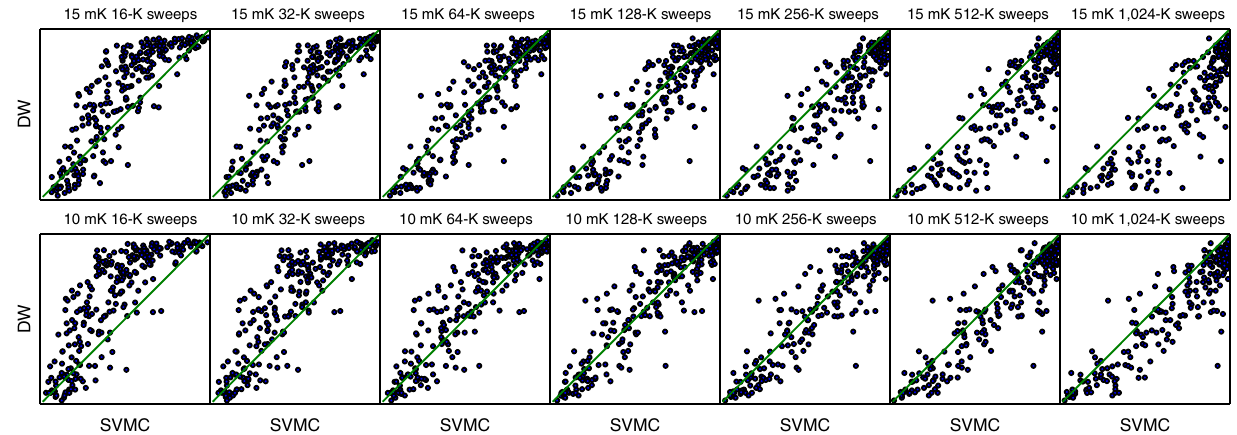
Figure 8 | Scatter plots showing the correlation of D-Wave Two data and SVMC. Correlations for the random Ising benchmark for different algorithmic temperatures (in mK) and number of sweeps. We will use the parameters T ¼ 15mK and sweeps ¼ 128,000 for SVMC in the rest of the paper.